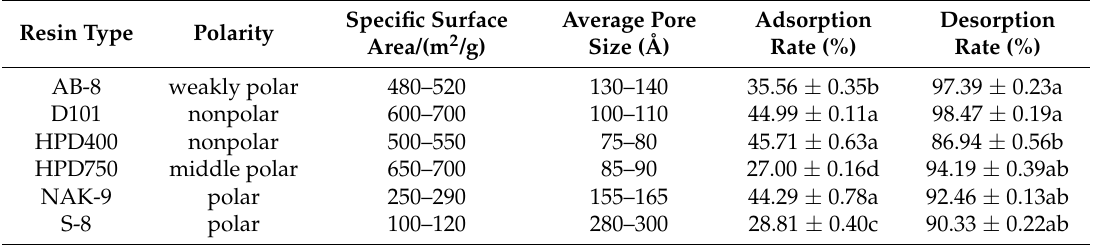
Table 1. Physical properties and adsorption and desorption rates of six types of macroporous resin.